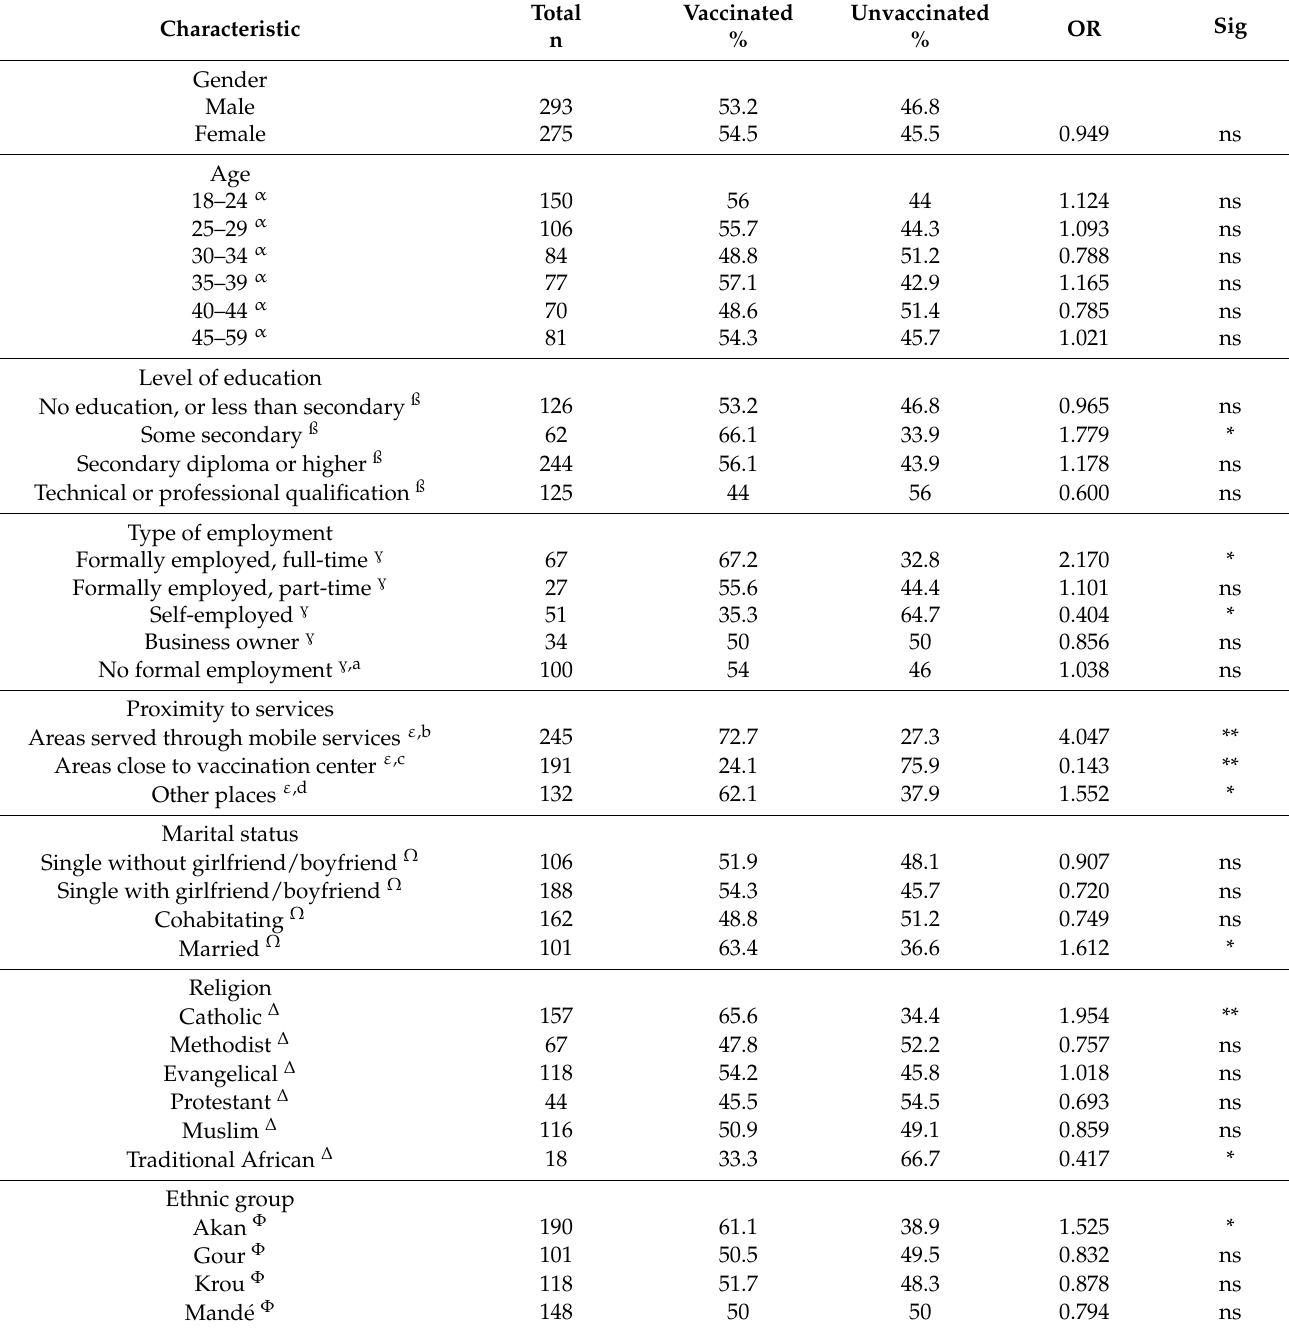
Table 1. COVID-19 vaccination status by socio-demographic